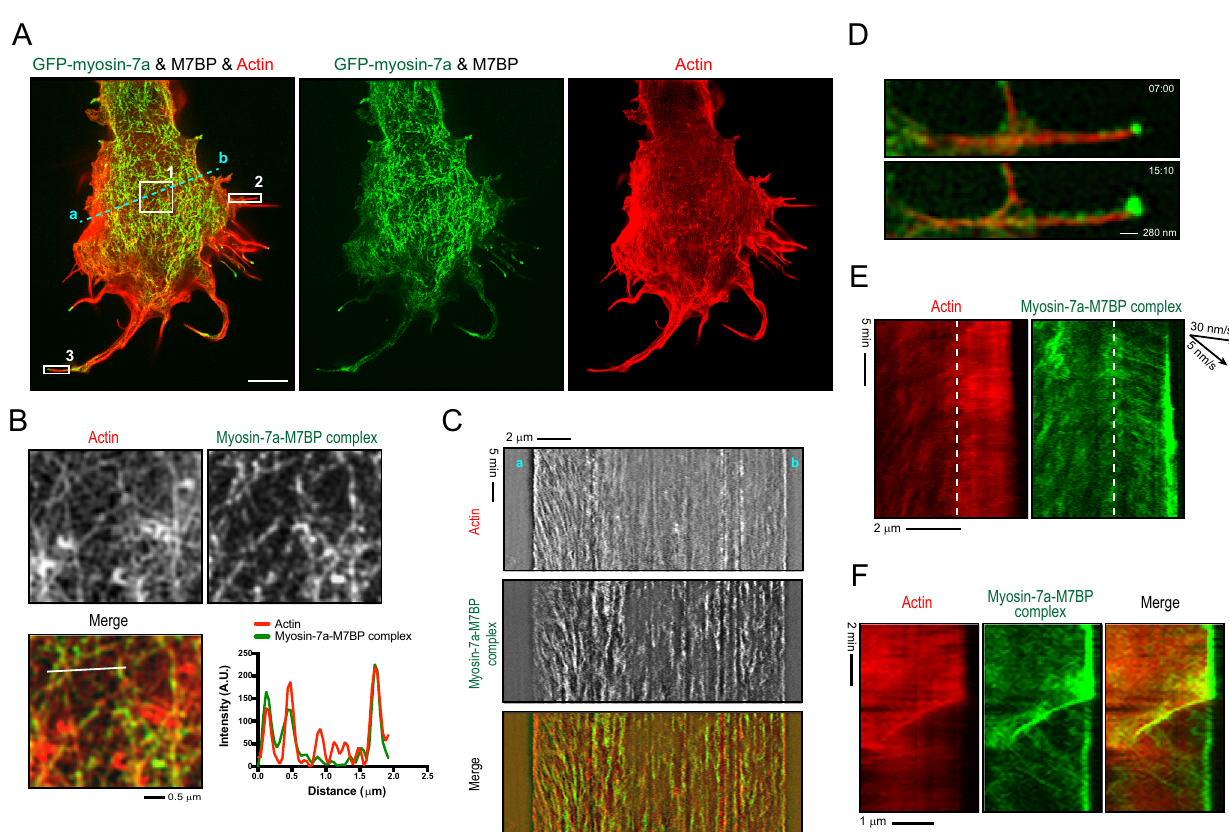
Fig. 6 Myosin-7a-M7BP complexes drive actin fi lament bundling and fi lopodia extension. A TIRF-SIM live-cell imaging reveals that expression of myosin-7a-M7BP complexes (visualized by a GFP tag to myosin-7a, green) produces substantial actin bundles in cell body and fi lopodial protrusions (actin was labeled with F-tractin-mCherry, red). Scale bars = 5 μ m. Fluorescent Images are representative of three independent experiments. B Magni fi ed insets of box 1 in A and line scans showing that actin networks is composed of densely packed actin fi laments and bundles. Myosin-7a-M7BP complexes are primarily colocalized with actin bundles that thus results in a “ fi lamentous appearance ” of the complexes. C Kymograph analysis (cyan dash sample line in A ) showing that myosin-7a complexes are associated with actin bundles during entire imaging period. Note a more vigorous actin retrograde fl ow was detected at one side of the cell edge (a), compared to the regions in cell body and in the opposite side (b) where actomyosin bundles are relatively static. Newly polymerized actin fi laments on the cell edge (a) were associated with less myosin-7a complex. D Magni fi ed images of box 2 in A showing single molecules of myosin-7a-M7BP complexes move along stable actin fi lament bundles, similar to the movement observed in vitro. Note the increase in tip intensity over time. E Kymograph analysis of box 2 in A reveals that while fi lopodial actin bundles remain stable, myosin-7a-M7BP complexes move forward to the tip of fi lopodia. The migration speed is comparable to the velocity measured in single-molecule assays or observed in live cells without actin labeling. The dash line indicates the cell edge. F Kymograph analysis of box 3 in A showing an example that fi lopodial bundles partially disassembled where a portion of the bundle retracted back towards the cell body. The associated myosin-7a complexes exhibit rearward movements along with the actin retrograde fl